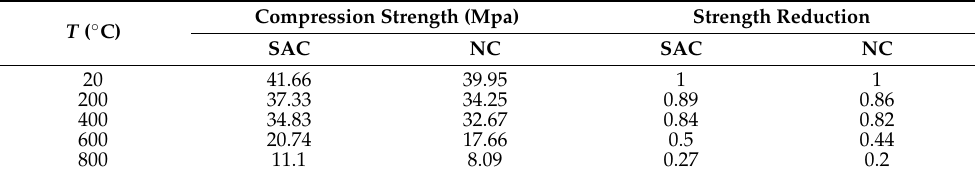
Table 2. Compression strength of specimens after high